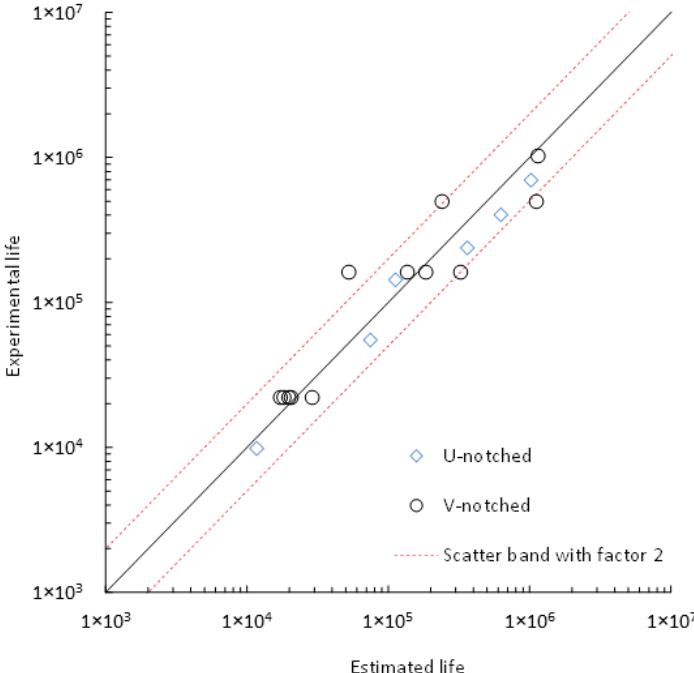
Figure 12. Estimation of fatigue life of U- and V-notched specimens based on the strain energy density criterion.